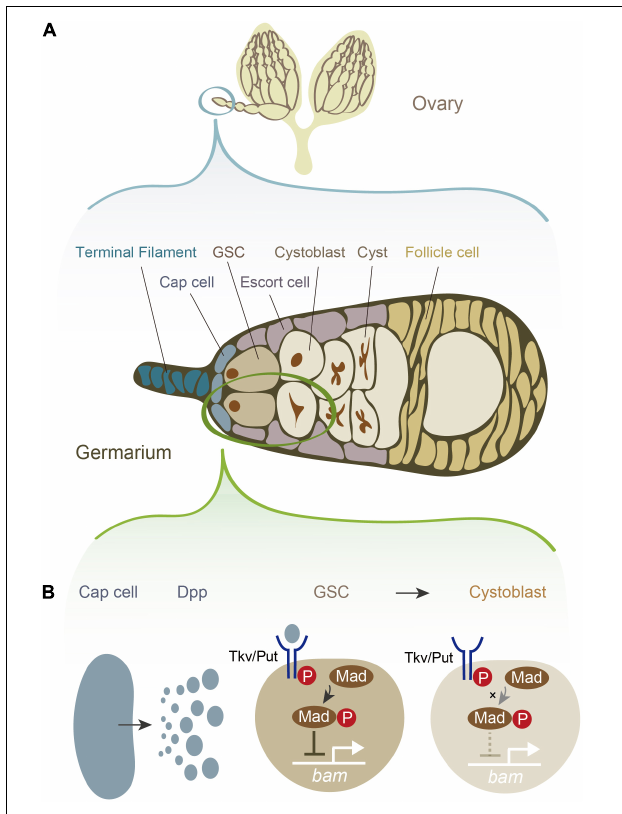
FIGURE 1 | Female germline stem cells (GSCs) and their niche signal in Drosophila melanogaster. (A) A schematic illustration of D. melanogaster ovary and germarium. The germarium is located at the anterior tip of the ovary. The germarium consists of both germ cells and somatic cells. Germ cells contain female GSCs, cystoblasts, cysts, and more differentiated oocytes. Somatic cells contain terminal filament cells, cap cells, escort cells, and follicle cells. While all of these somatic cells contribute to the niche in some degree, the most important source of the niche signal is thought to be cap cells. (B) The niche signal from cap cells. Cap cells secrete Decapentaplegic (Dpp). Dpp is received by its receptor, a heterodimer of Thick vein (Tkv) and Punt (Put). The activated Dpp signaling eventually phosphorylates the signal transduction molecule Mother-against-dpp (Mad). The phosphorylated Mad (pMad) transcriptionally represses bag-of-marbles ( bam ). As bam is essential for promoting the cystoblast differentiation from female GSCs, the repression of bam is conversely essential for maintaining